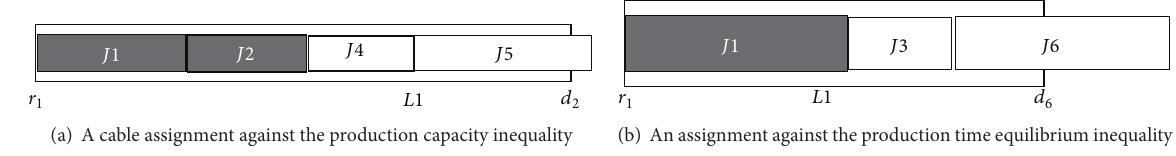
Figure 2: Cable assignments excluded by the valid